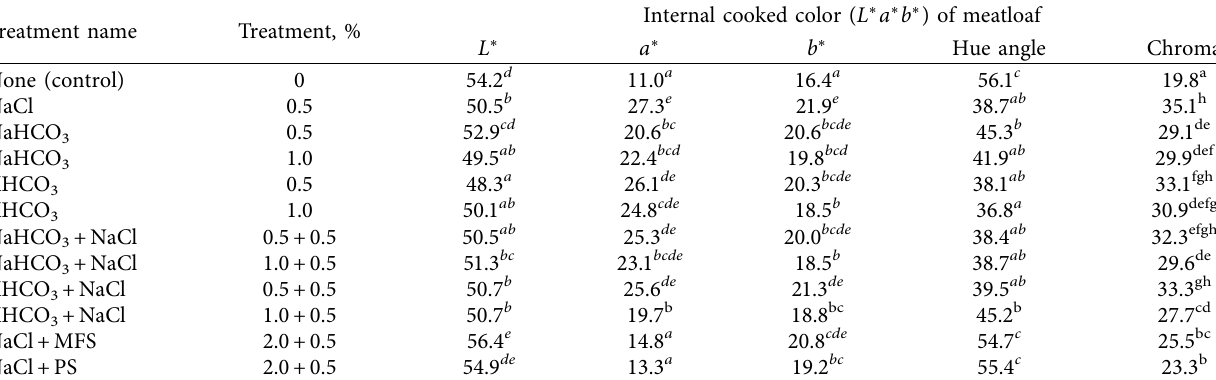
Table 6: Least-squares mean for surface colorimeter readings of L ∗ (lightness), a ∗ (redness), b ∗ (yellowness), hue angle, and saturation index (chroma) of meatloaf treated with different levels of sodium bicarbonate, potassium bicarbonate, salt, modified food starch, and potato starch.